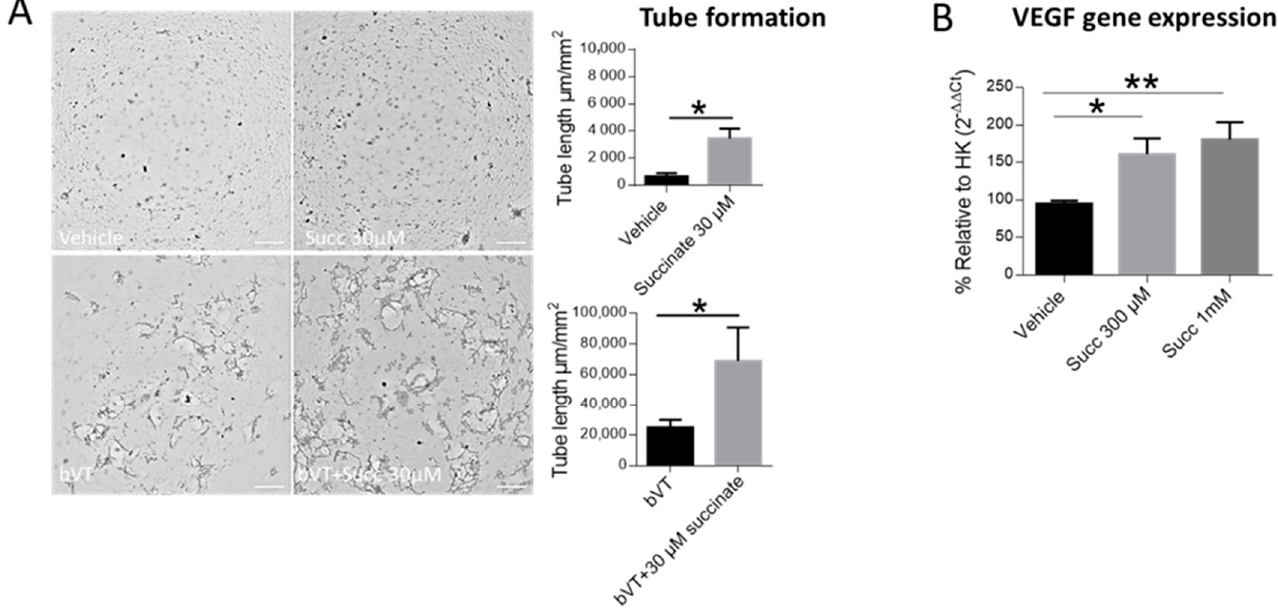
Figure 7. Succinate induces capillary structure formation as well as VEGF gene expression in FpECAs. ( A ) Tube formation assay in FpECAs treated with vehicle or succinate either alone or in combination with the positive control bVT. Tube length was calculated as µm per mm 2 ; paired t-test, * p < 0.05, data are mean ± SEM ( n = 4). Images are representative of 4 independent experiments (scale bar 500 µ M, objective 4 × ). ( B ) RT-PCR of FpECAs treated with vehicle or succinate for 4 h and analyzed by one-way ANOVA followed by Dunnett’s post hoc test, * p < 0.05, ** p < 0.01, data are shown as mean ± SEM ( n =